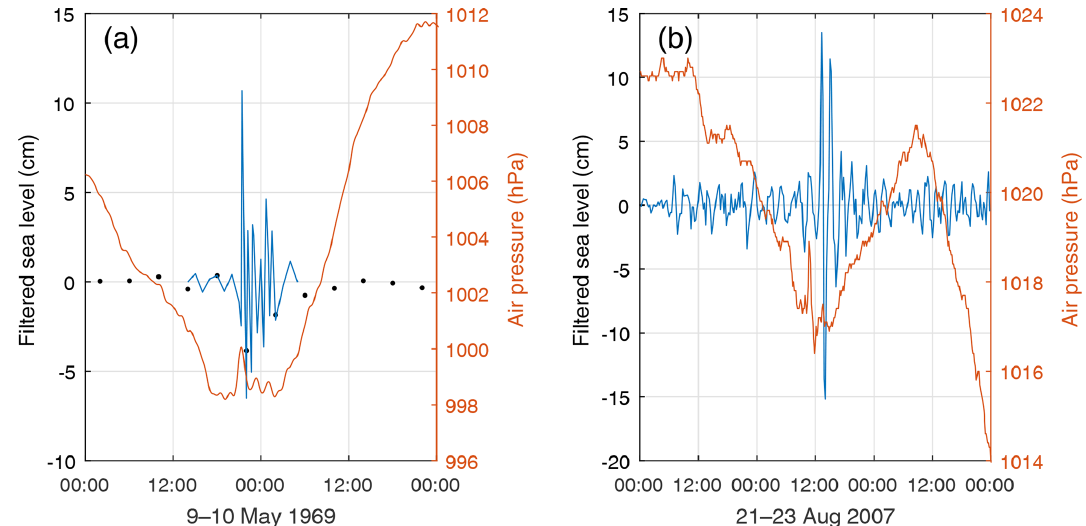
Figure 4. (a) A meteotsunami in Hanko on 9–10 May 1969, visually identified and digitised from the tide gauge charts. Black dots show the standard 4h sea level observations. Air pressure observations from Hanko Russarö, digitised from a paper barogram, are plotted in red. (b) A meteotsunami in Hamina on 22 August 2007, automatically detected from the high-pass filtered 15min sea level data. Air pressure observations from Kotka Rankki are plotted in red.